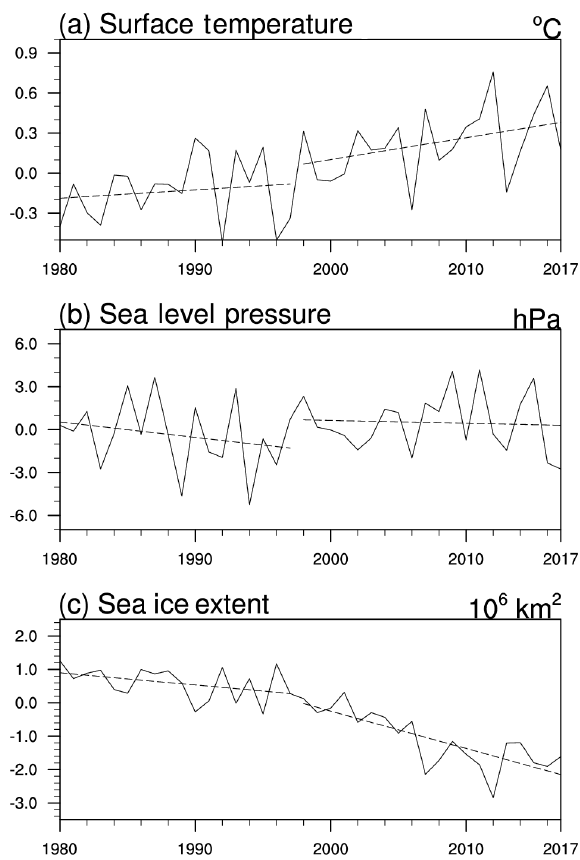
Figure 1. (a) Surface temperature and (b) sea level pressure anoma- lies in the Arctic region north of 70 ◦ N during June–July–August (JJA). (c) is the sea ice extent (SIE) in September in the same area. The anomalies are the departures from the average of 1981–2010. The dashed line shows the trend before and after